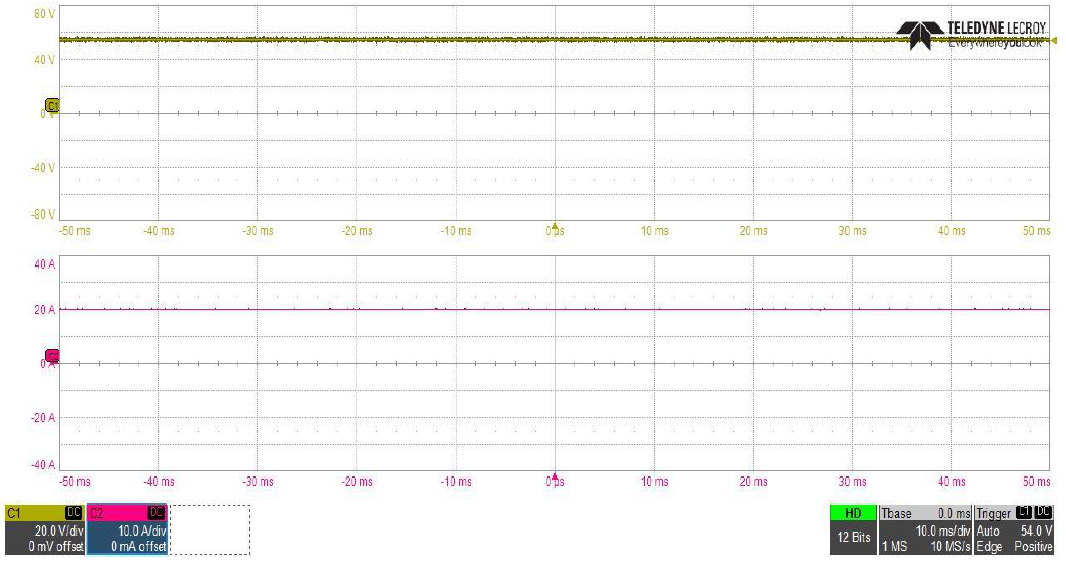
Figure 22. DC – DC converter stage output voltage and current waveforms at V in = 400 V. Figure 22. DC–DC converter stage output voltage and current waveforms at V